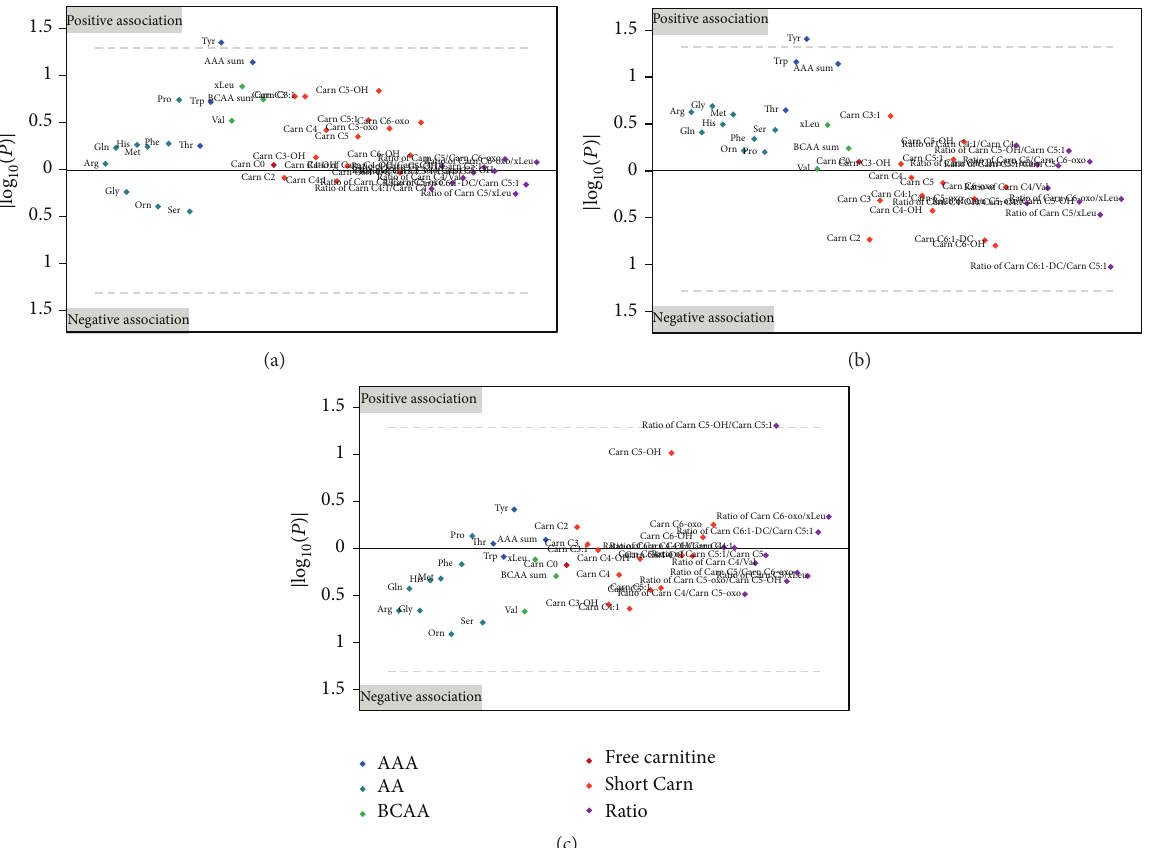
Figure 3: Manhattan plot for associations of amino acids (AA) and acylcarnitines (Carn) with HOMA after the one-year lifestyle intervention for all obese children (a), children with substantial weight loss (b), and children without substantial weight loss (c). Plotted are the log 10 (𝑝) values and the sign is used to indicate the direction of the relationship, as assessed by the robust regression model. The area below or above the dashed lines contains metabolites that are significantly related to HOMA ( 𝑝 values < 0.05). AAA, aromatic amino acids; BCAA, branched- chain amino